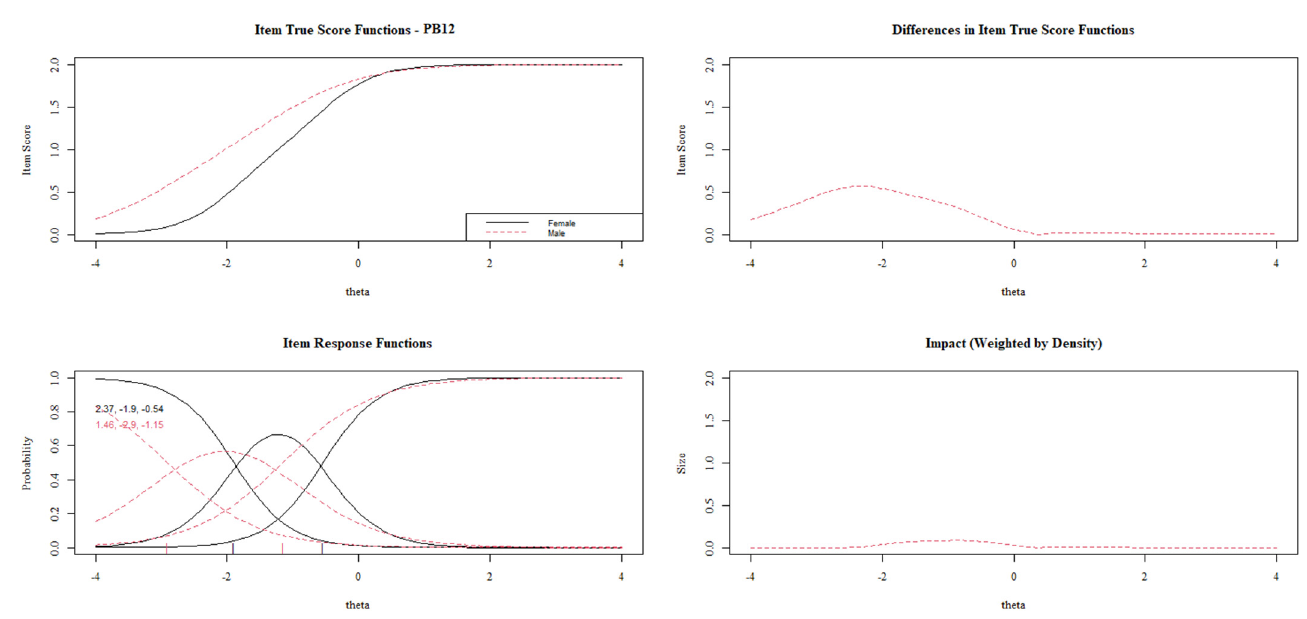
Figure 5. DIF plots for items PB12.